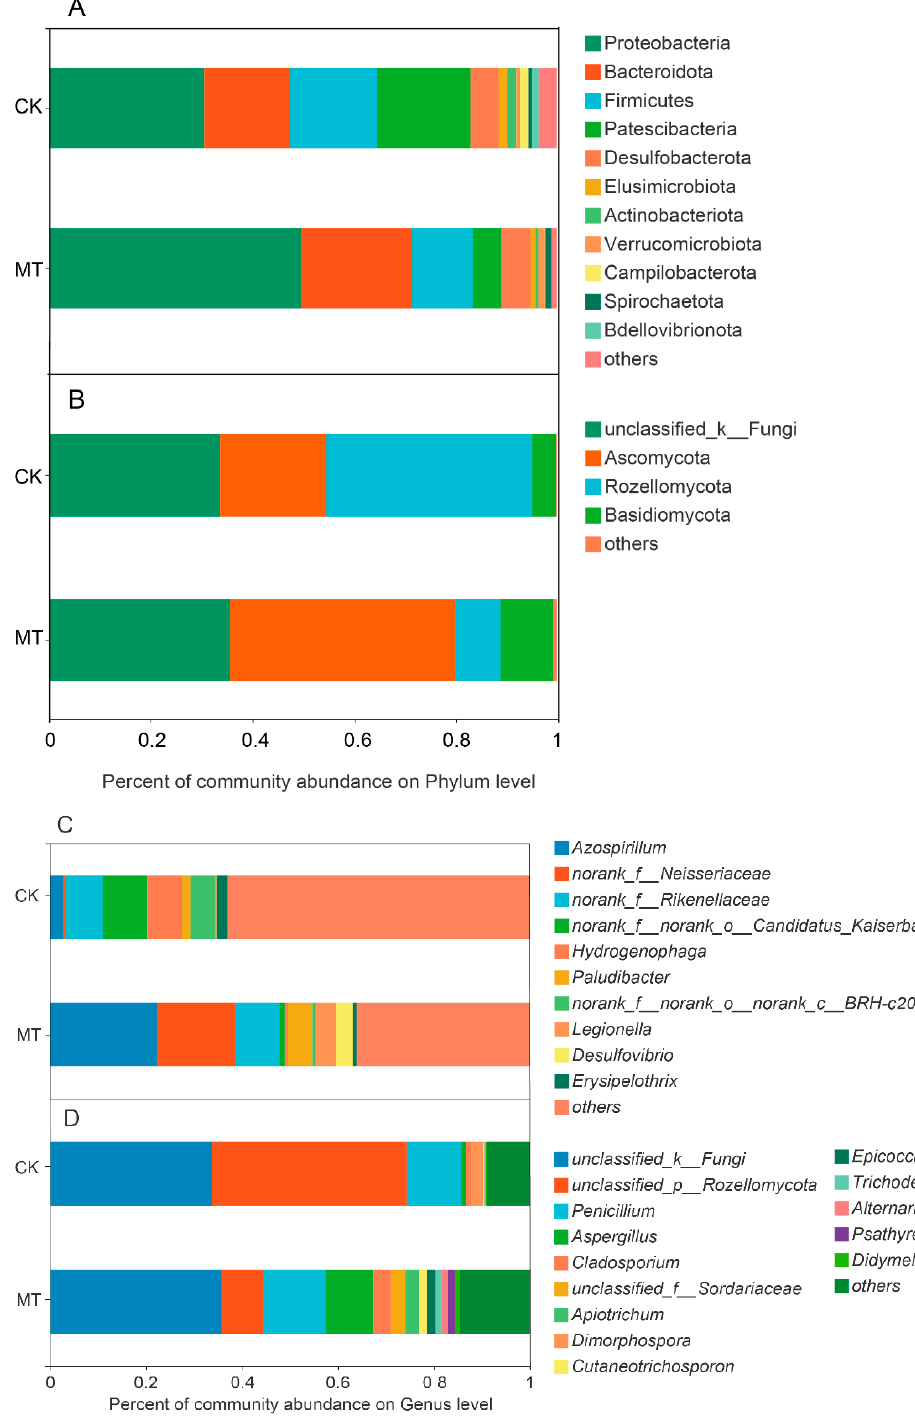
Figure 6. The relative abundance of bacteria ( A , C ) and fungi ( B , D ) community structure at the phylum and genus level after treatment for 7 days under control (CK) and melatonin (MT) conditions in wastewater.